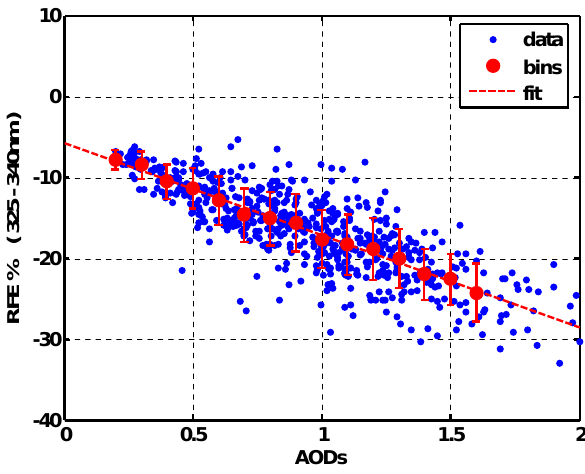
Figure 1. Percent change (%) of the irradiance at the 325-340nm wavelength integral Fig. 1. Percent change (%) of the irradiance at the 325–340nm wavelength integral versus the AOD slant. Data represent measure- versus the AOD slant. ments of June–August